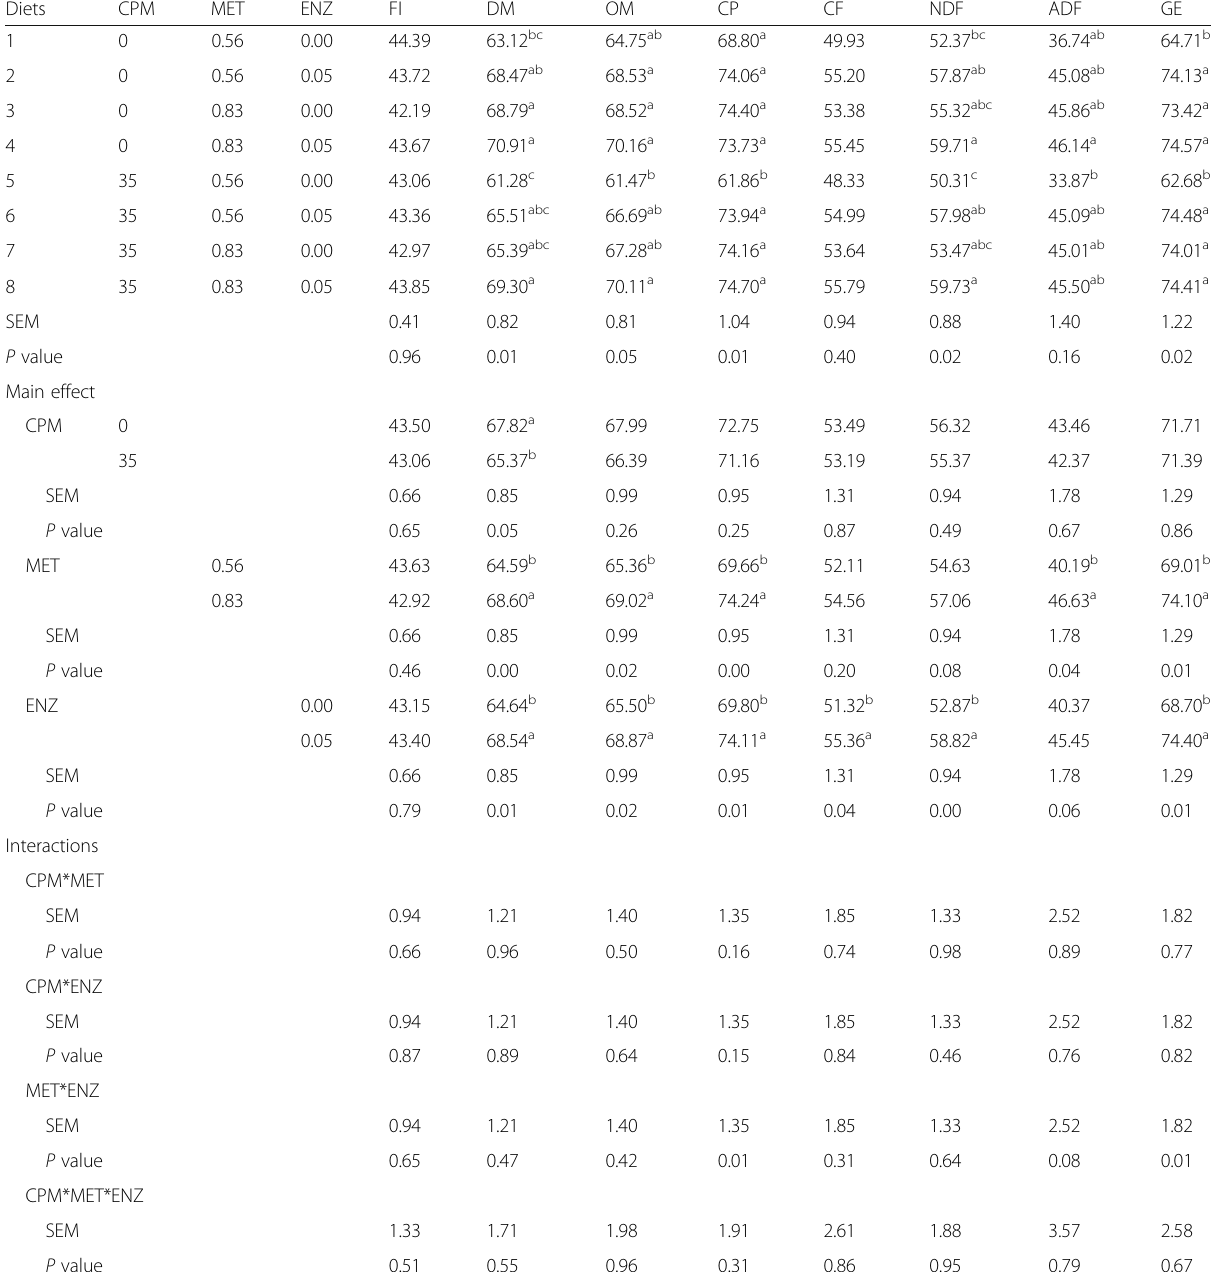
Table 4 Effect of cassava peel meal inclusion (%), methionine (%) and multi-enzyme (%) supplementation on nutrient utilization (%) in